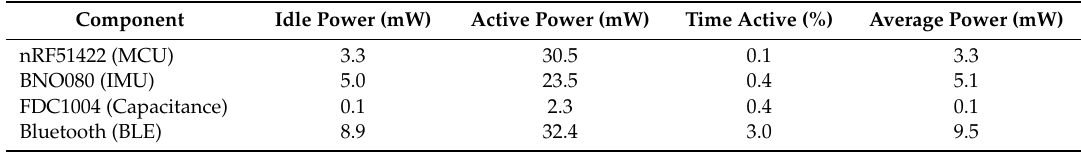
Table 2. Power budget calculations for printed circuit boards (PCB) components after machine learning results.